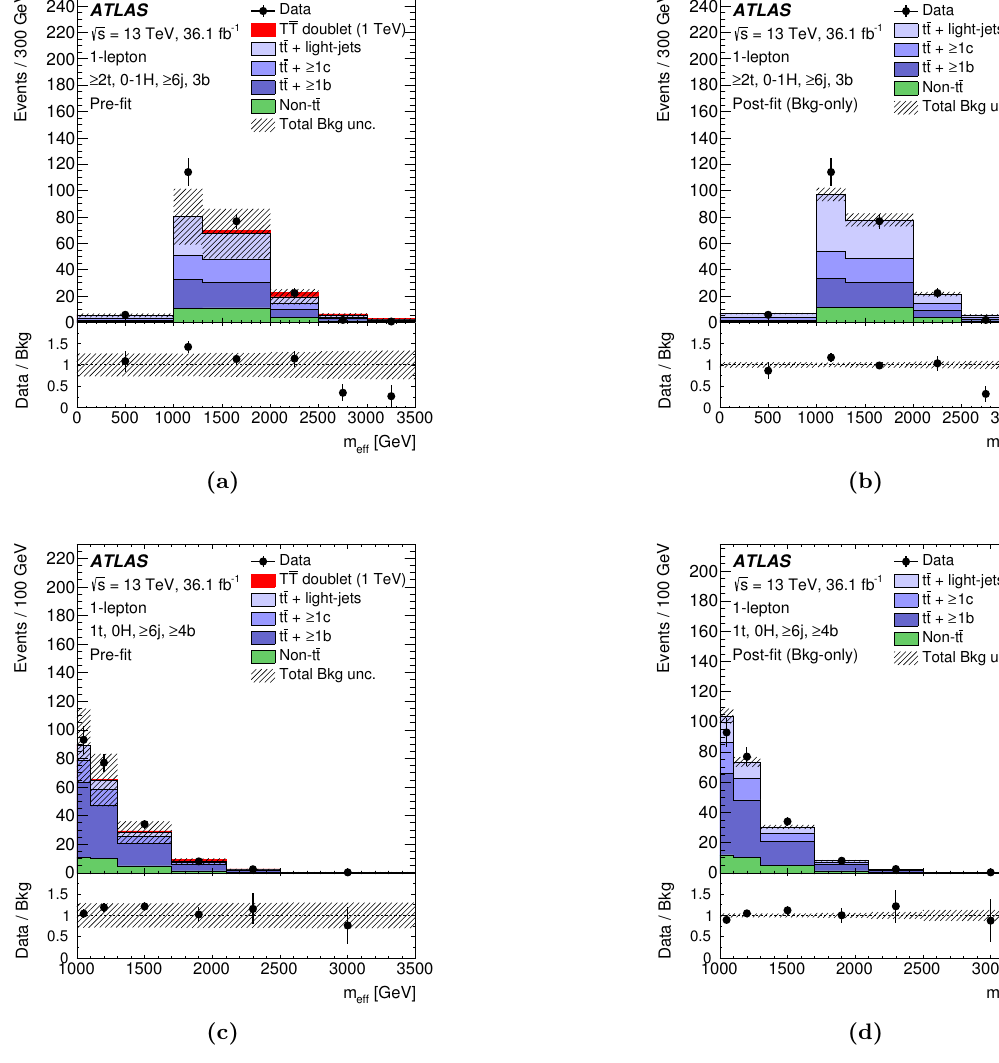
Figure 9. Comparison between the data and prediction for the m e(cid:11) distribution in some of the most sensitive search regions in the 1-lepton channel, before and after performing the combined (cid:12)t to data in the 0-lepton and 1-lepton channels (\Pre-(cid:12)t" and \Post-(cid:12)t", respectively) under the background-only hypothesis. Shown are the ( 2t, 0{1H, 6j, 3b) region (a) pre-(cid:12)t and (b) post-(cid:12)t, (cid:21) (cid:21) and the (1t, 0H, 6j, 4b) region (c) pre-(cid:12)t and (d) post-(cid:12)t. In the pre-(cid:12)t (cid:12)gures the expected T (cid:22) T (cid:21) (cid:21) signal (solid red) corresponding to m T = 1 TeV in the T doublet scenario is also shown, added on top of the background prediction. The small contributions from t (cid:22) tV , t (cid:22) tH , single-top, W=Z +jets, diboson, and multijet backgrounds are combined into a single background source referred to as \Non- t (cid:22) t ". The last bin in all (cid:12)gures contains the over(cid:13)ow. The bottom panels display the ratios of data to the total background prediction (\Bkg"). The hashed area represents the total uncertainty of the background. In the case of the pre-(cid:12)t background uncertainty, the normalisation uncertainty of the t (cid:22) t + 1 b background is not (cid:21)